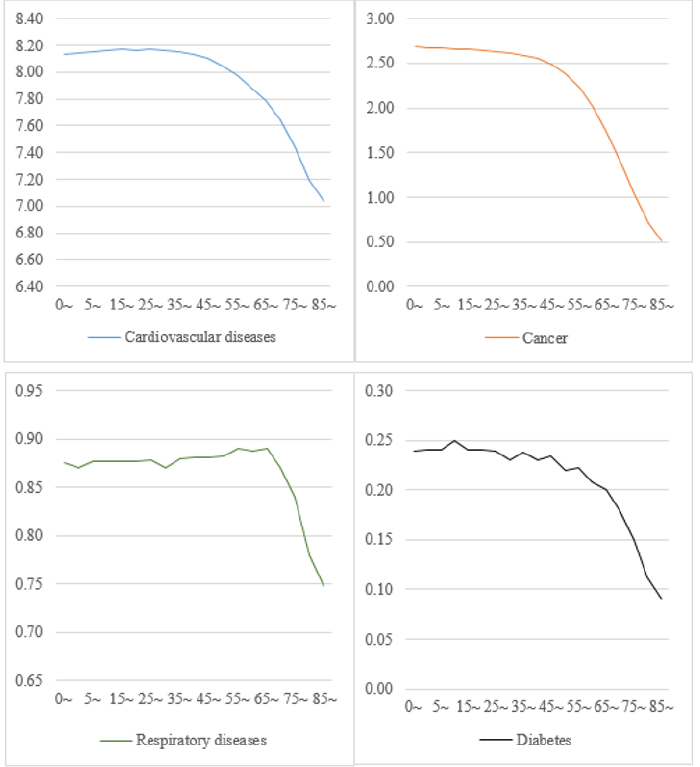
Figure 2. Increases in life expectancy by age group after eliminating diseases’ deaths. China, 2019. When classified by region, the LE of residents in the Eastern, Central, and Western regions after removing CVD deaths was 88.07, 88.93, and 85.18 years, representing increases of 7.64, 9.87, and 7.00 years, respectively. LE increased by 2.94, 2.60, and 2.35 years in the eastern, central, and western regions, respectively, after eliminating cancer deaths. After eliminating deaths from respiratory disease, LE increased by 0.67 years in the eastern region, 0.74 years in the central region, and 1.41 years in the western region. LE rose by 0.25 years in the east, 0.23 years in the central part, and 0.24 years in the West after removing deaths from diabetes (Table 2). Table 2. Increases in life expectancy by gender and type of residential district after eliminating dis- eases’ deaths. China, 2019.